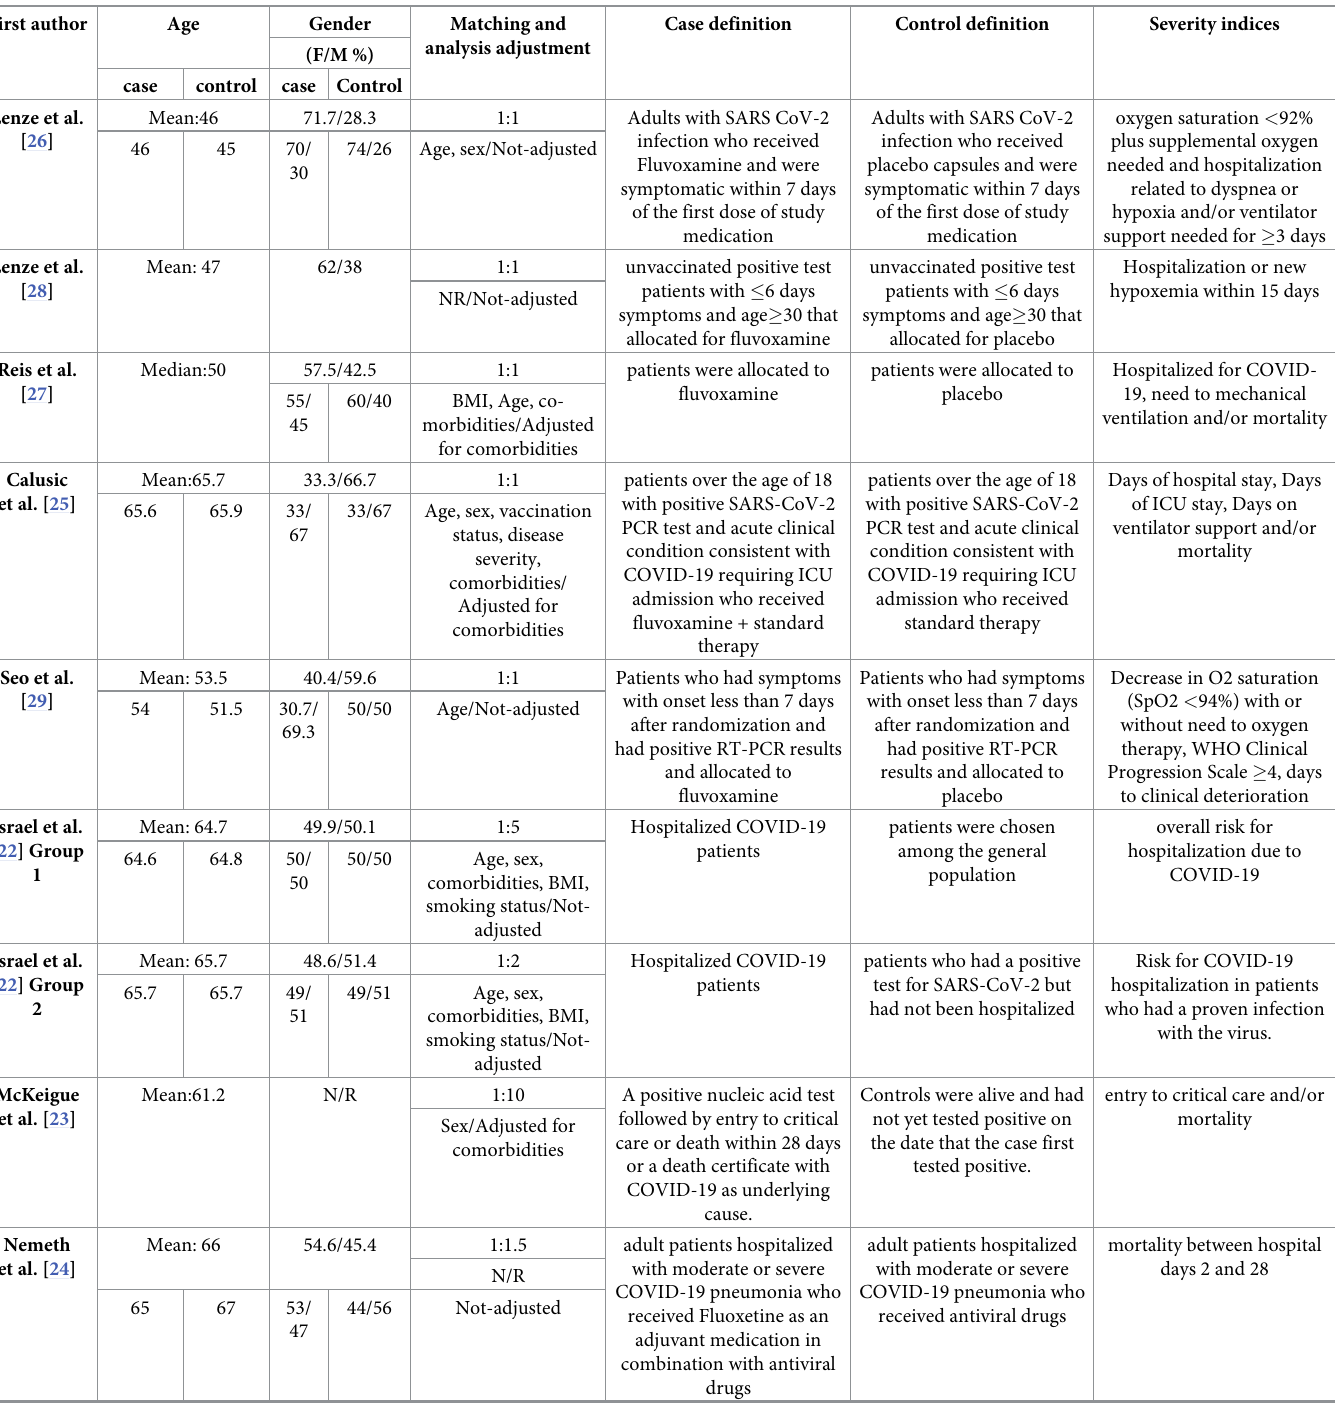
Table 5. Patient